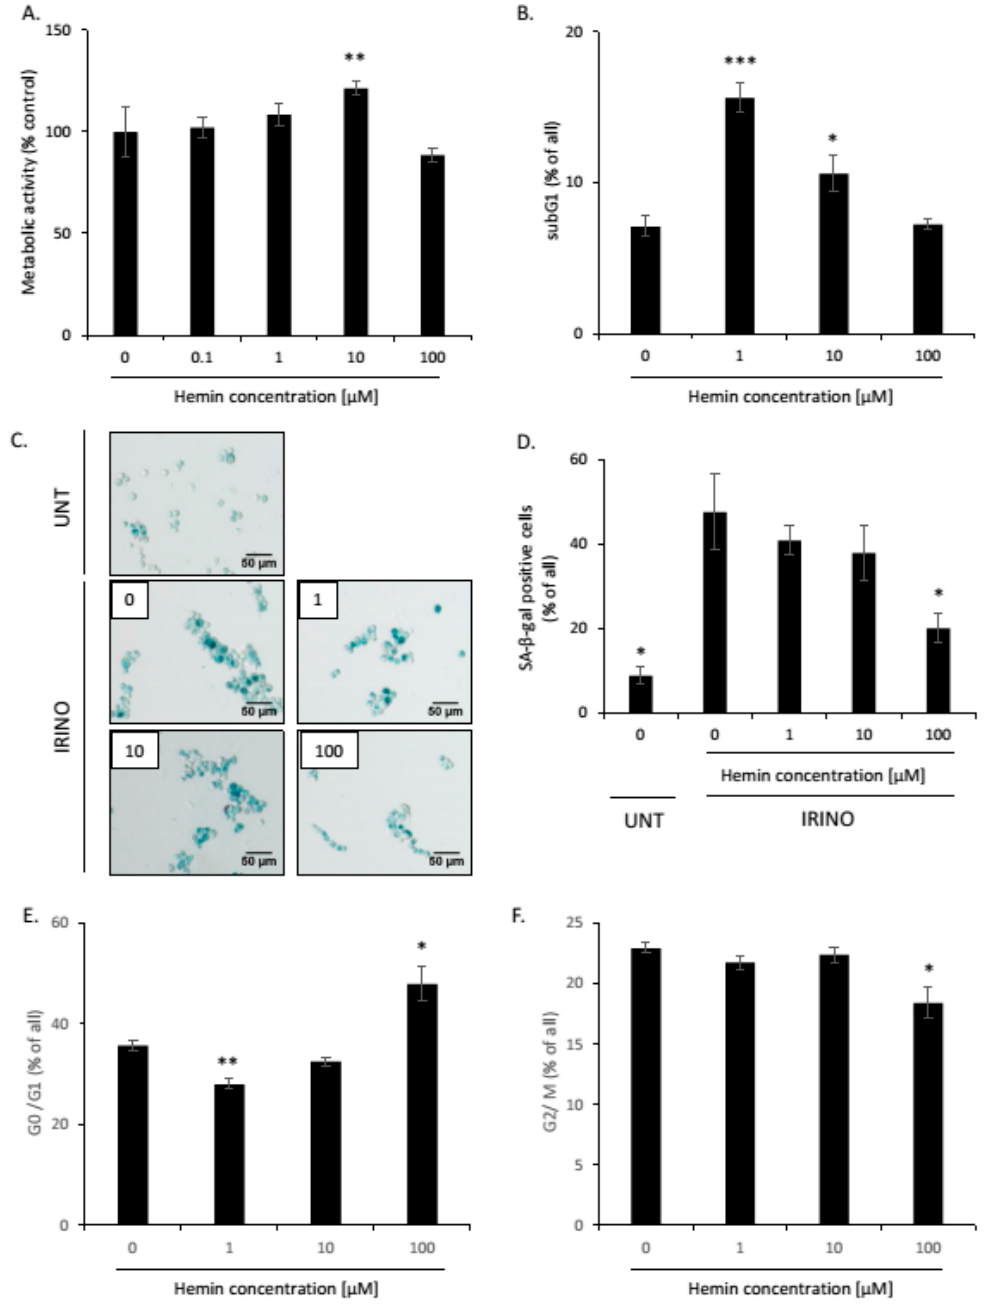
Figure A10. High hemin concentration correlates with an escape from the senescence of SW480 cells. SW480 cells were subjected to 2.5 µM of irinotecan (IRINO) and 1, 10, or 100 µM of hemin. After 24 h, the medium was changed and the cells were cultured in a drug-free medium for 4 days. ( A ) Evaluation of metabolic activity assayed by MTT metabolism. ( B ) Quantification of the percentage of cells in the subG1 phase (with DNA content < 2C). Cell cycle analysis was performed with the use of Cell Cycle Analysis Kit (Sigma) and flow cytometry. ( C ) Activity of SA- β -Galactosidase enzyme in UNT and IRINO-treated cells subjected to hemin. Detection of the enzyme was performed on cytospined cells. Representative photos were acquired using light microscopy. Original magnification 200×, scale bar 50 µM. ( D ) Quantification of SA- β -Gal positive cells after treatment with hemin. ( E , F ) Quantification of the percentage of cells in the G0/G1 ( E ) or G2/M phases ( F ). Cell cycle analysis was performed with Muse TM Cell Cycle Reagent and flow cytometry. Each bar represents mean ± SEM, n ≥ 3. * p < 0.05, ** p < 0.01, *** p < 0.001—hemin concentration vs.